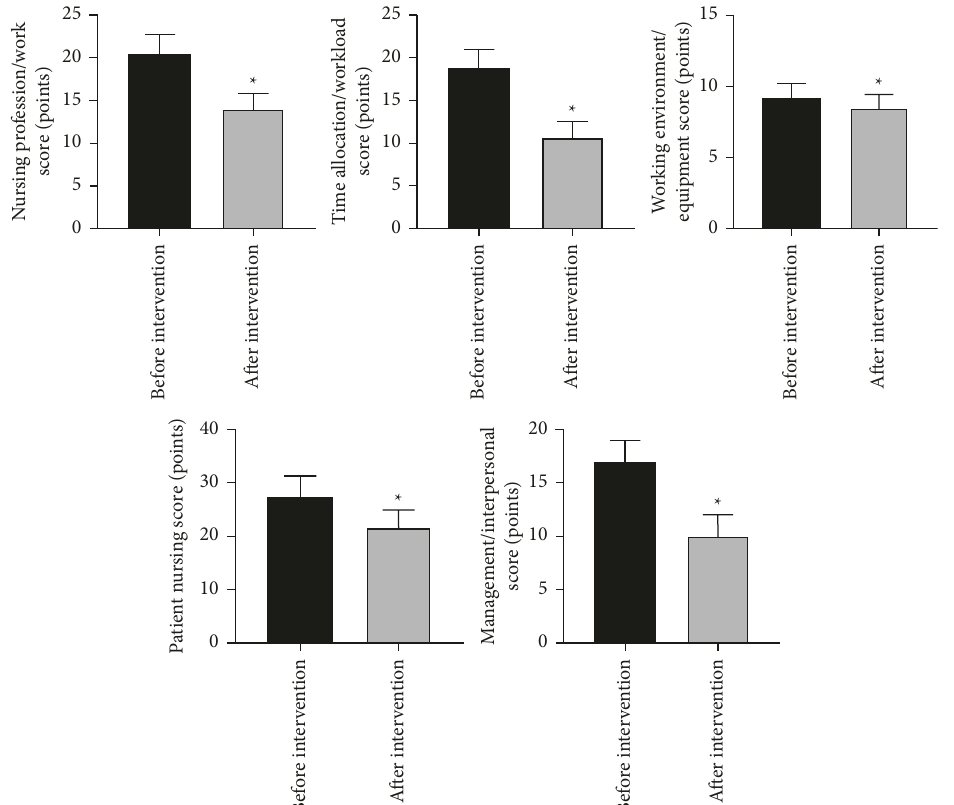
Figure 2: Comparison of work stress before and after intervention compared with before intervention, ∗ P < 0 . 05. Comparison of stress response before and after